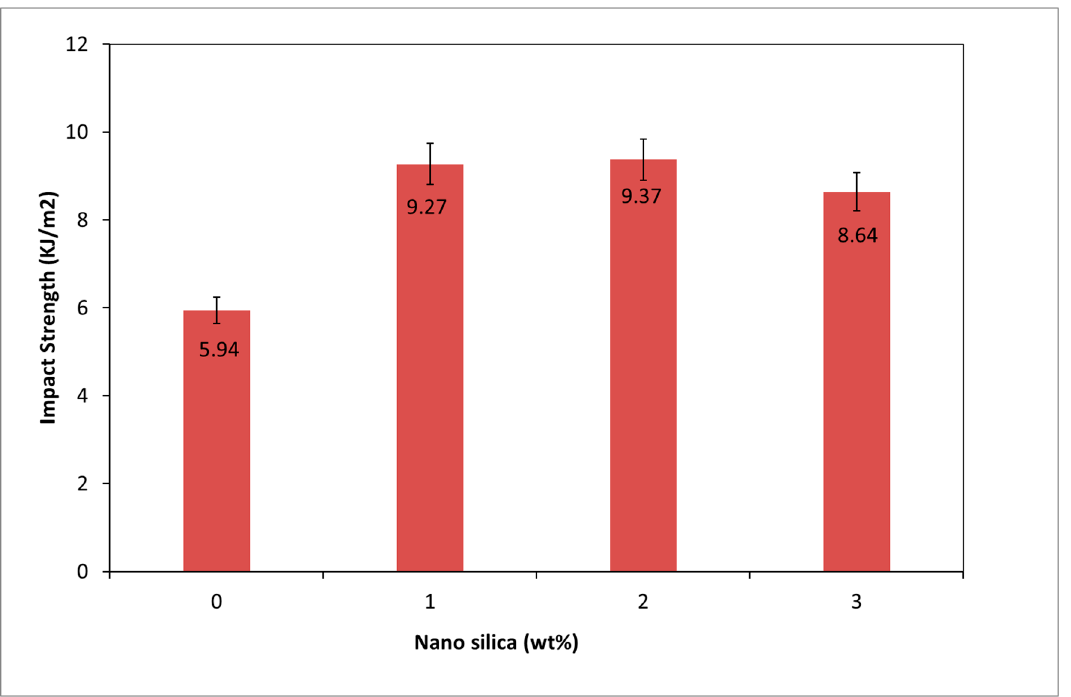
Figure 6. Variation of impact strength of geopolymer composites as a function of nanosilica content.